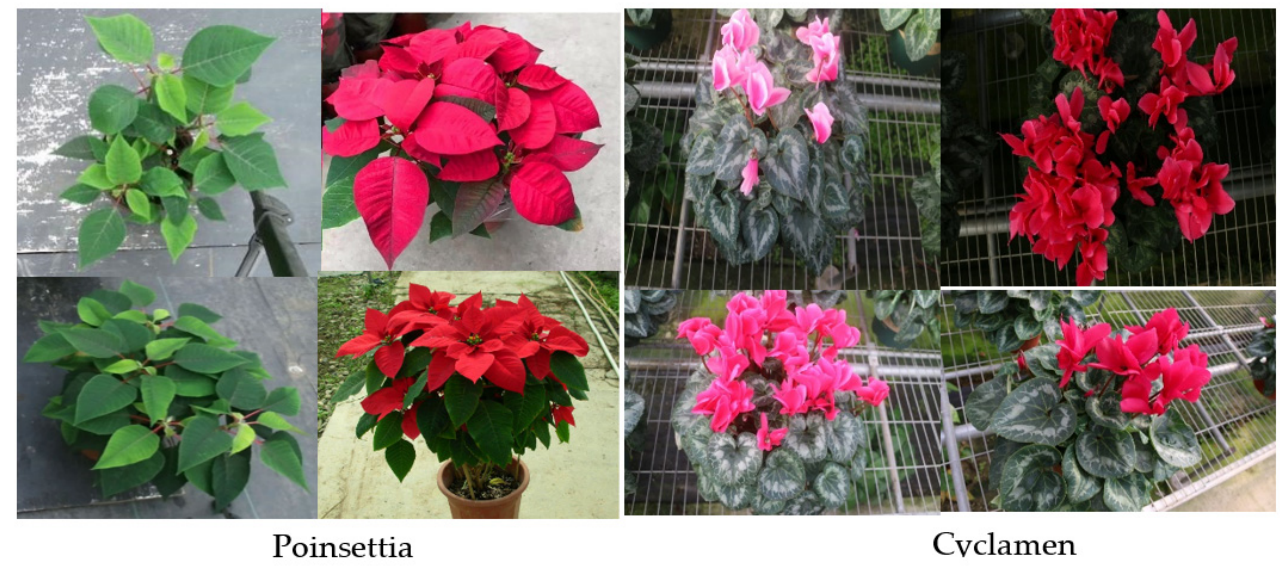
Figure 2. Poinsettia and cyclamen images collected for the YOLO V4-Tiny model training.